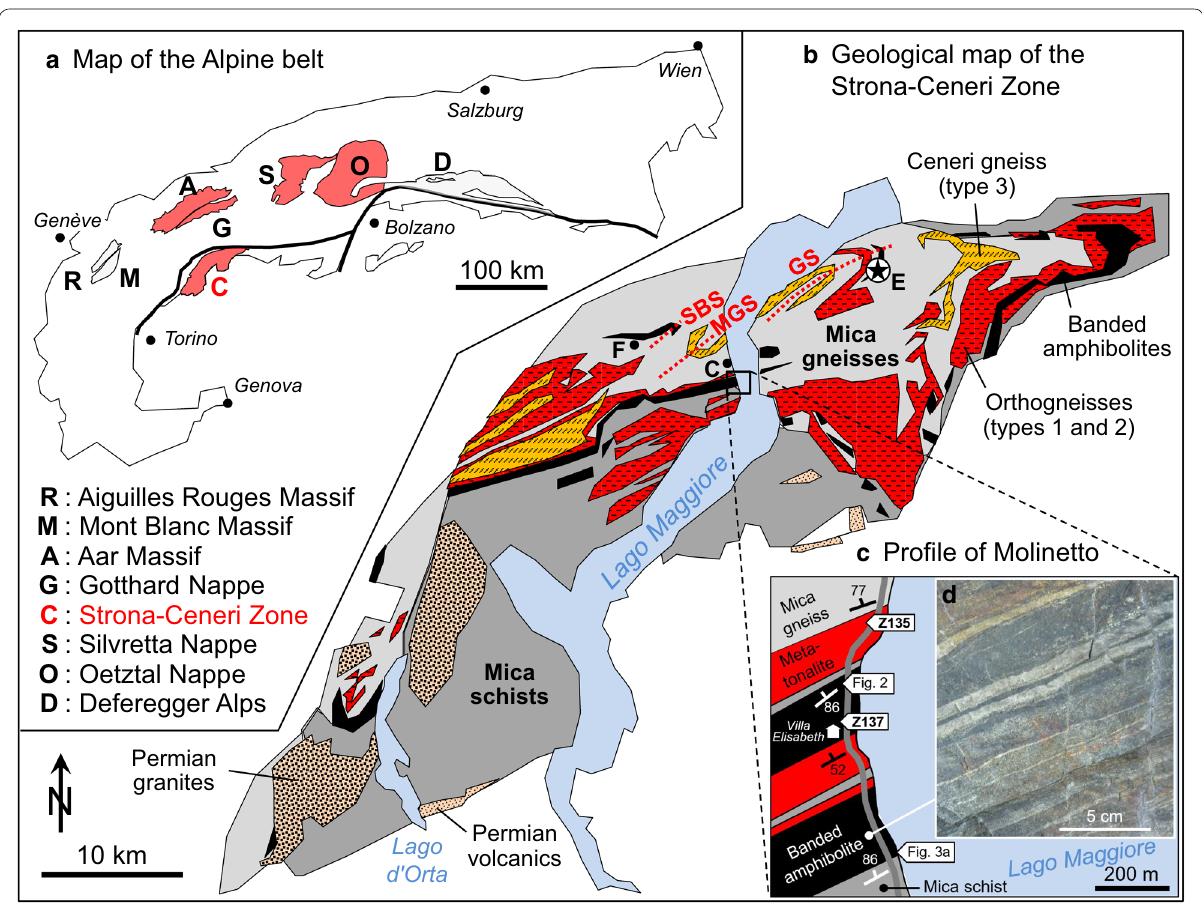
Fig. 1 a Map of Alpine belt (after Von Raumer et al. 2013) with high-lighted pre-Mesozoic basement units for which Ordovician orthogneisses and large-scale Schlingen folds are reported. b Geological map of the Strona-Ceneri Zone (after Boriani et al. 1990). The types of orthogneisses are defined in Table 1. (Abbreviations: C: Cannobio, F: Ponte Falmenta, E: location of eclogite sample from Franz and Romer (2007), SBS: San Bartolomeo Schlinge, MGS: Monte Giove Schlinge, GS: Gambarogno Schlinge). c Road profile of Molinetto (Villa Elisabeth, c. 1.5 km south of Cannobio,